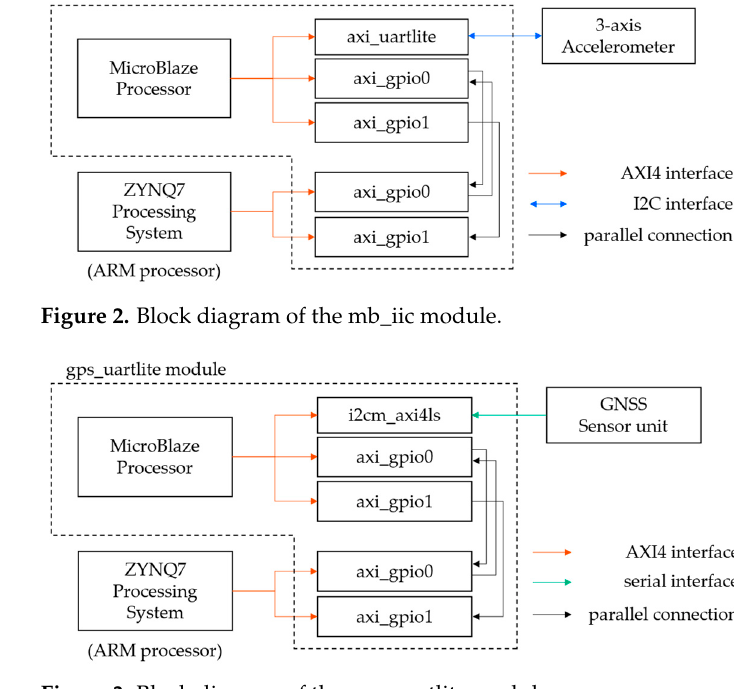
Figure 3. Block diagram of the gps_uartlite module.